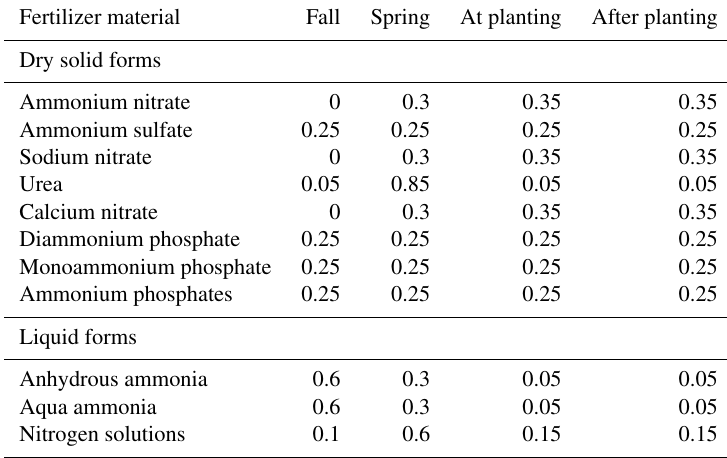
Table 1. Application timing ratio of 11 N fertilizer types. Ammonium phosphates are the integration of ammonium phosphate compounds in different formula.